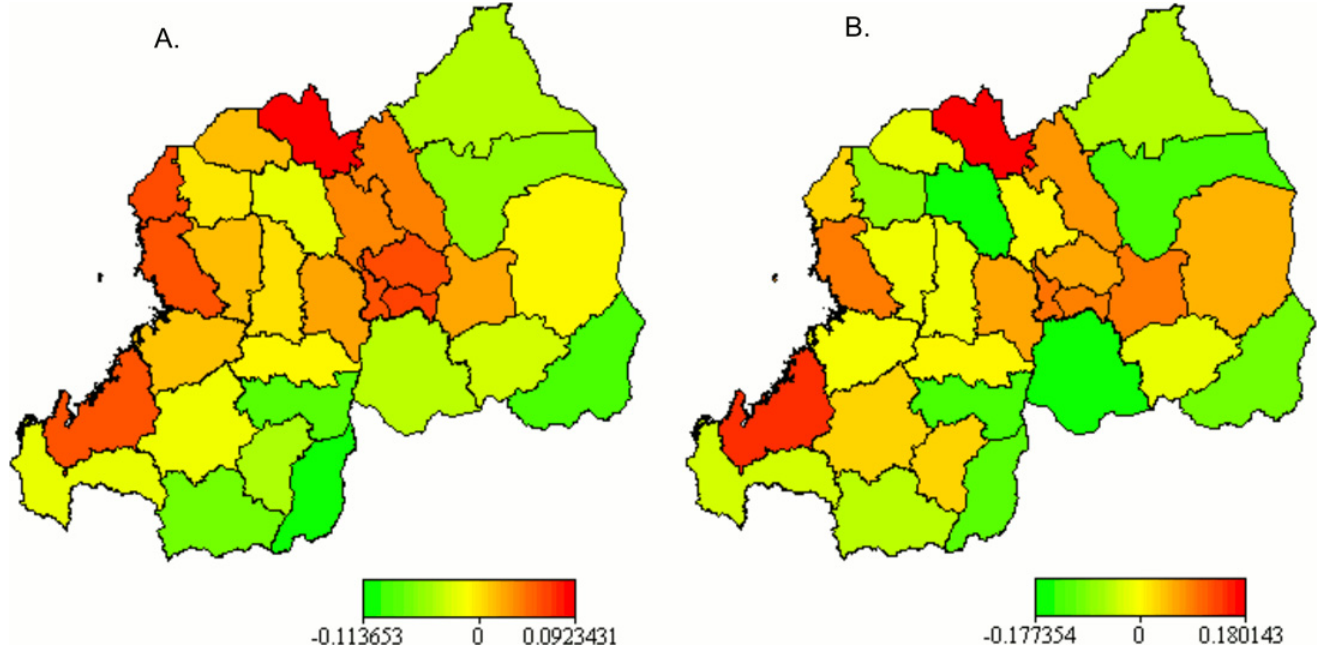
Fig 5. Posterior mean of the adjusted structured (A) and unstructured (B) spatial effects.